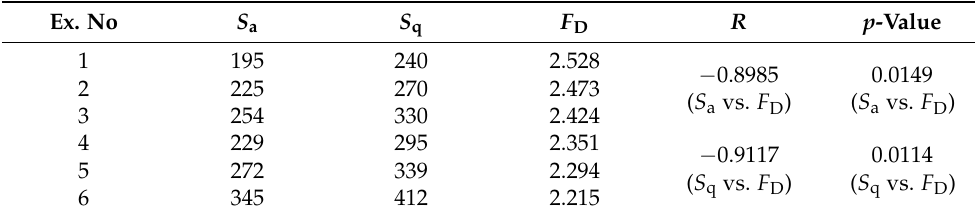
Table 1. Calculated correlation between 3D fractal dimension and surface roughness.